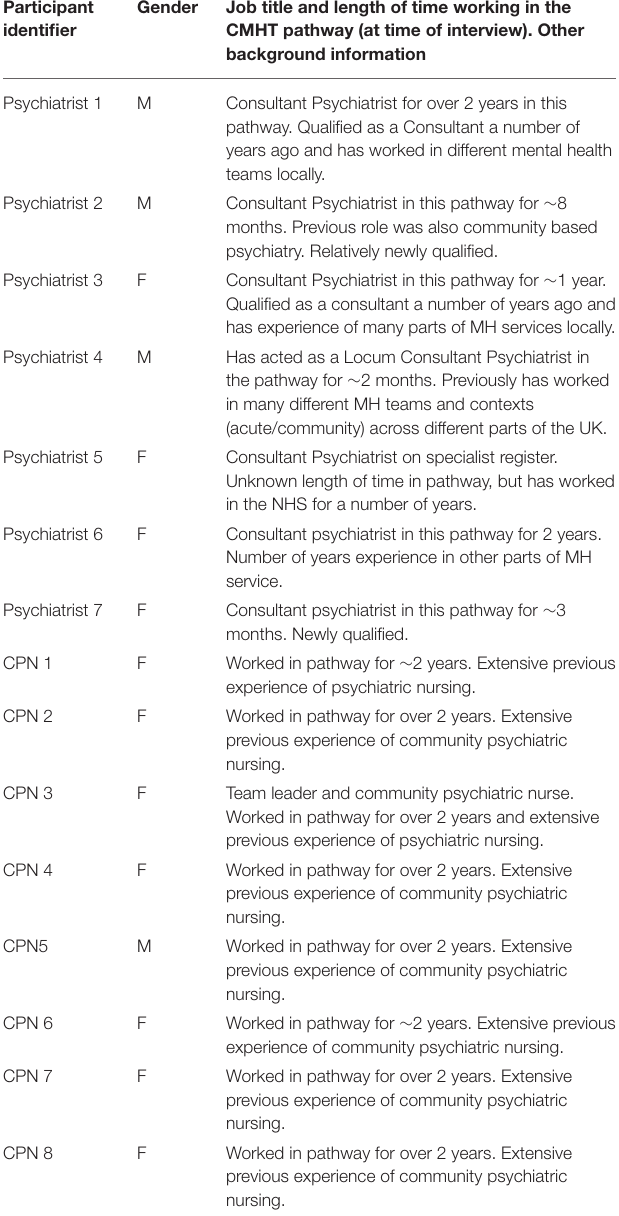
TABLE 2 | Clinician participant